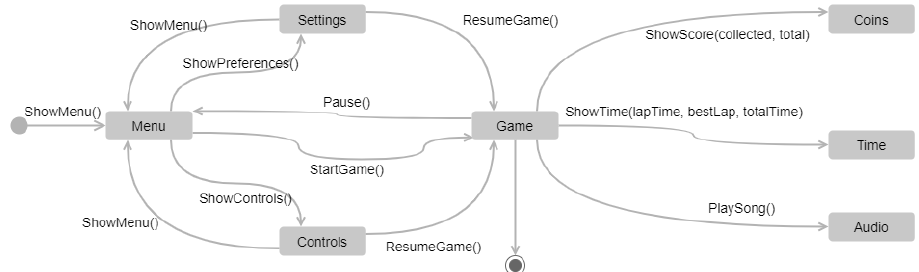
Figure 14. Scene diagram of the virtual environment user interface.